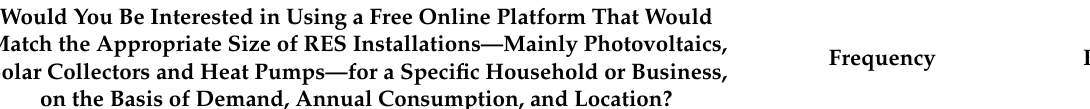
Table 13. The interest of consumers in the RES digital technology platform.